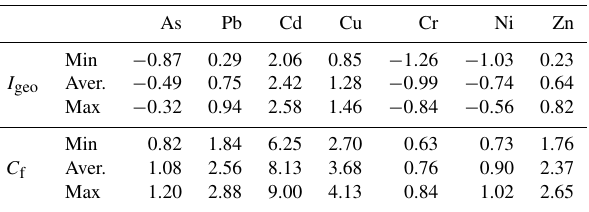
Table 5. Pollution index for trace elements in sediments of the study area ( n =